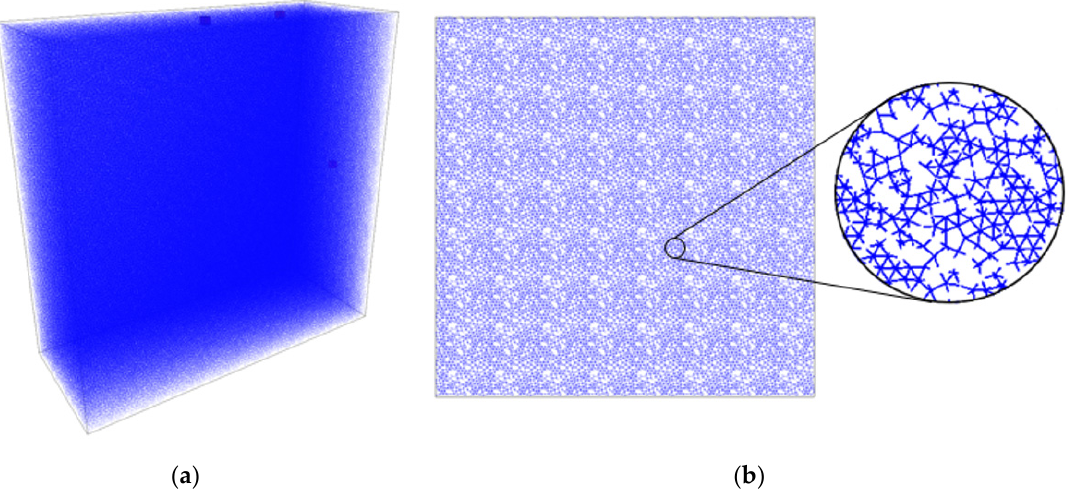
Figure 3. Illustrating ( a ) the LS-SRM intact model with monitoring points of force and displacement in z and x directions, ( b ) a vertical cross-section at the center of the spring lattice model.